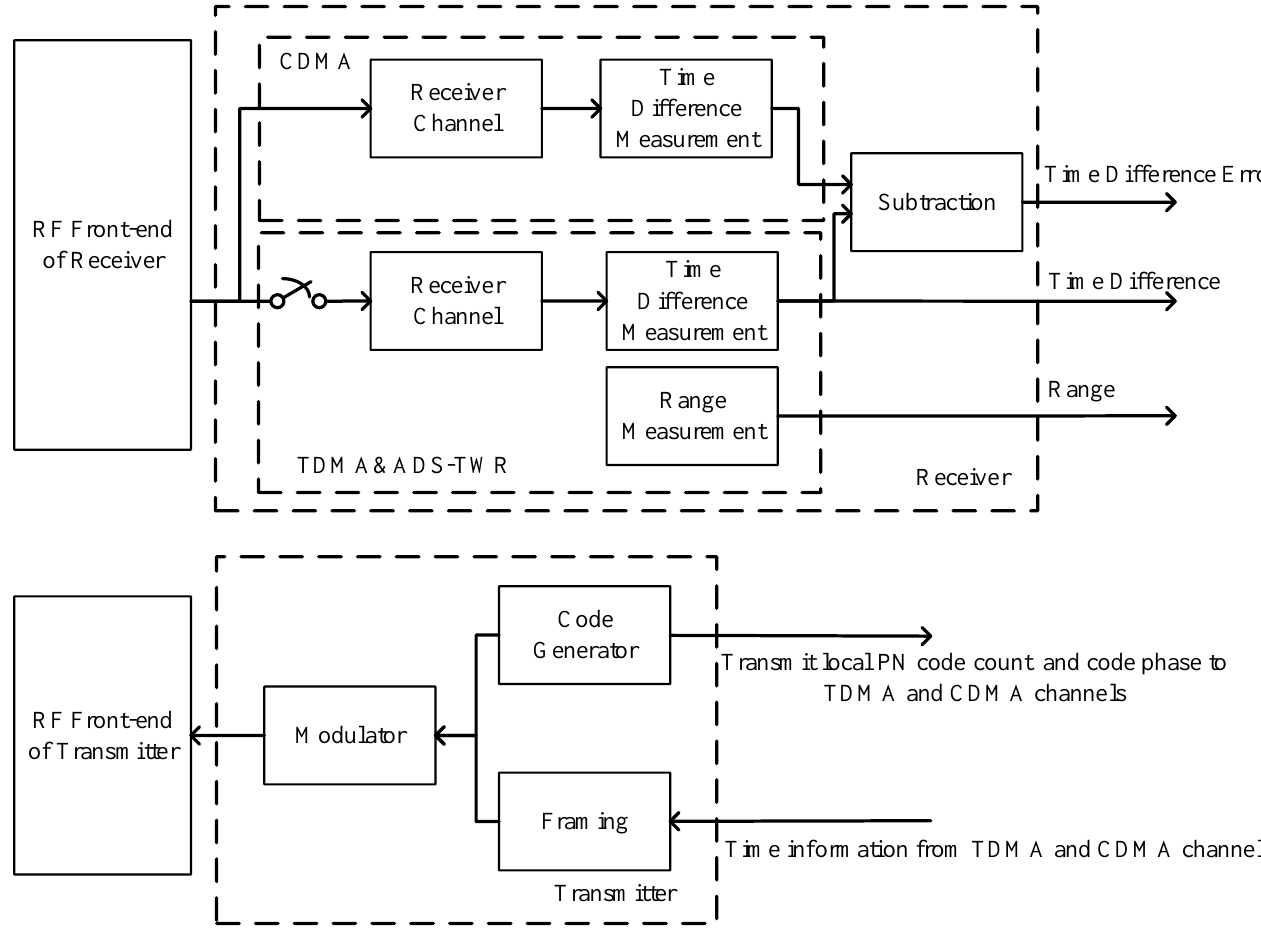
Figure 13. Joint measurement module. Table 4. Main specifications of the RF measurement transceiver.